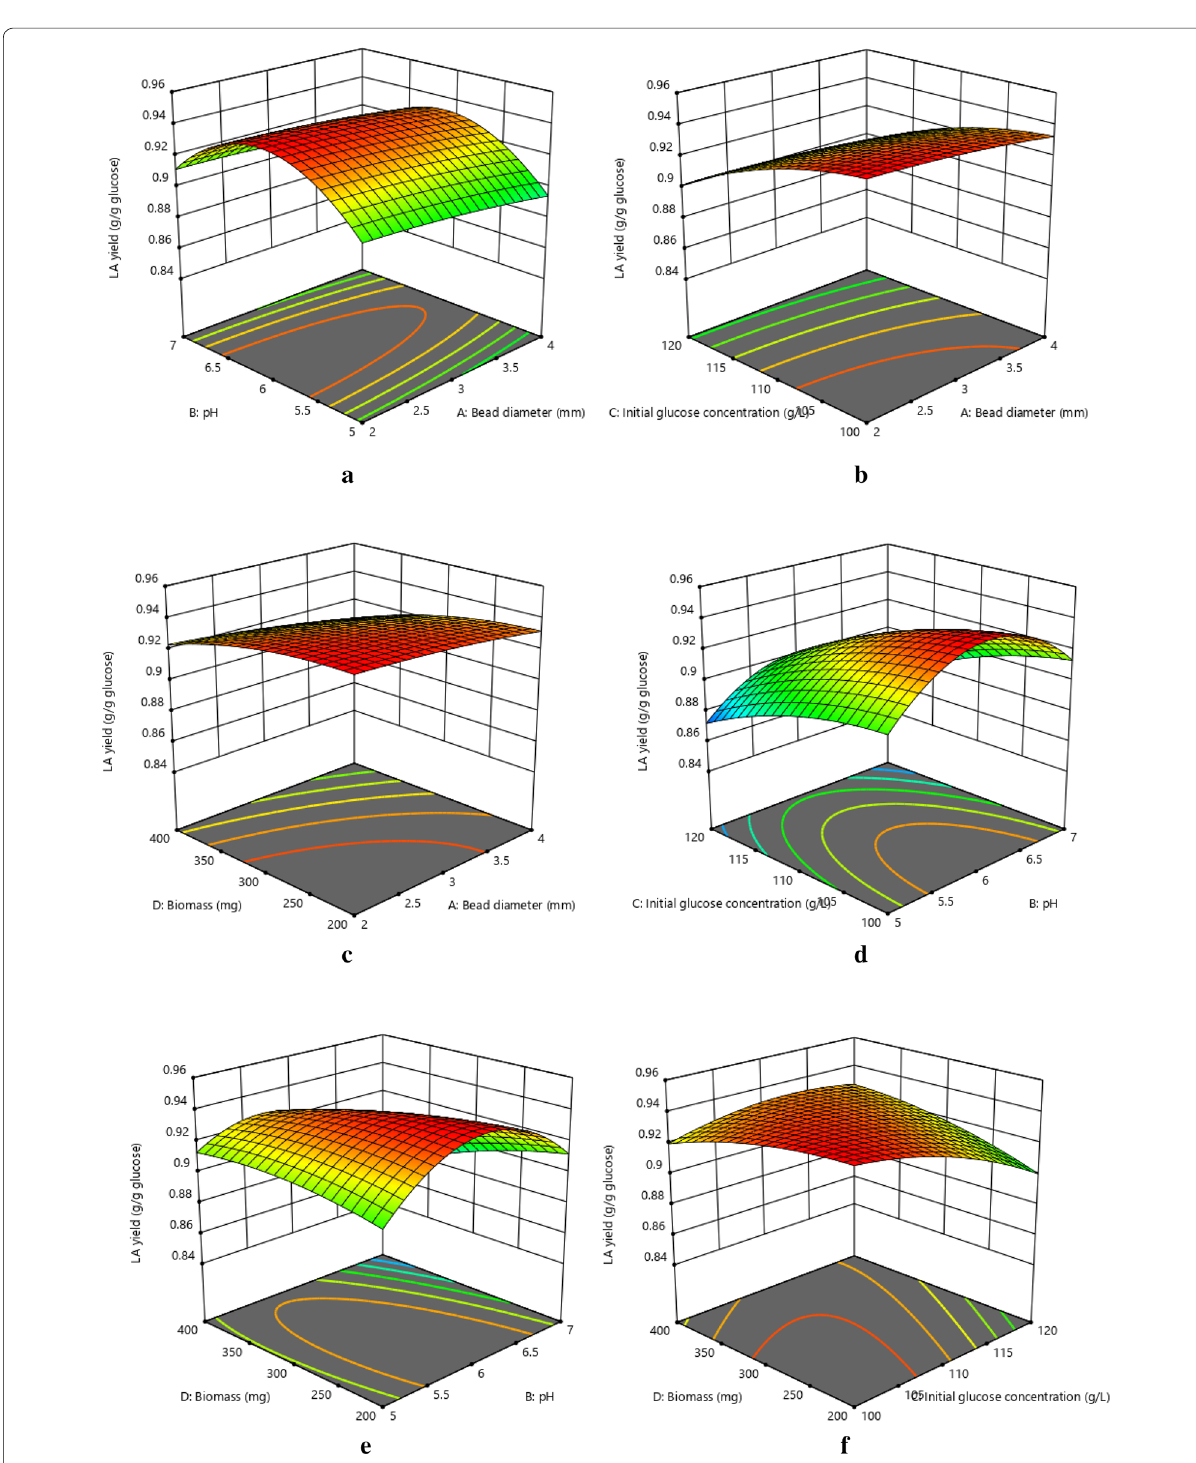
Fig. 1 Response surface of LA yield affected by a bead diameter and pH at 101.9 g/L initial glucose concentration and 204.6 mg biomass (CDW); b bead diameter and initial glucose concentration at pH 5.99 and 204.6 mg biomass (CDW); c bead diameter and biomass at pH 5.99 and 101.9 g/L initial glucose concentration; d pH and initial glucose concentration at 2.0 mm bead diameter and 204.6 mg biomass (CDW); e pH and biomass